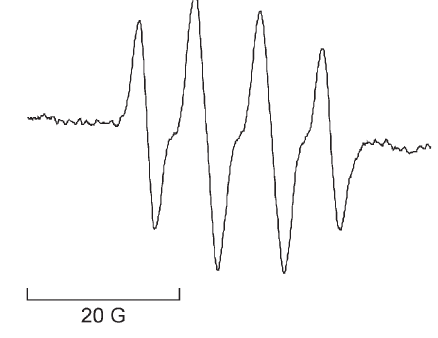
Figure 1. ESR spectrum of the DMPO/O